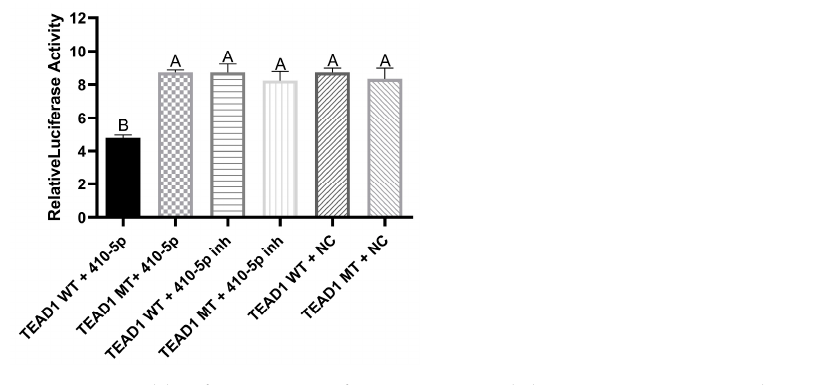
Figure 6. Dual luciferase assay of miR-410-5p and the TEAD1 gene. A and B represent extremely significant results.